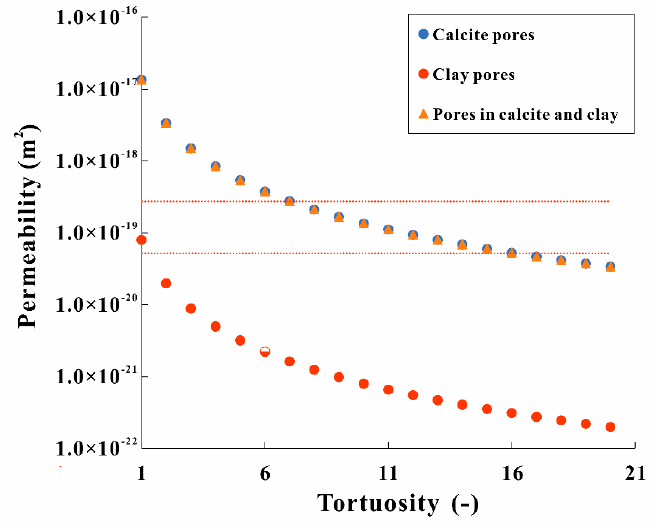
Figure 12. Simulated permeability coefficients based on a range of tortuosity values ( ≥ 1) and 2D pore cross-sections in calcite, clay and both mineral phases of map 1. The dashed bounds are